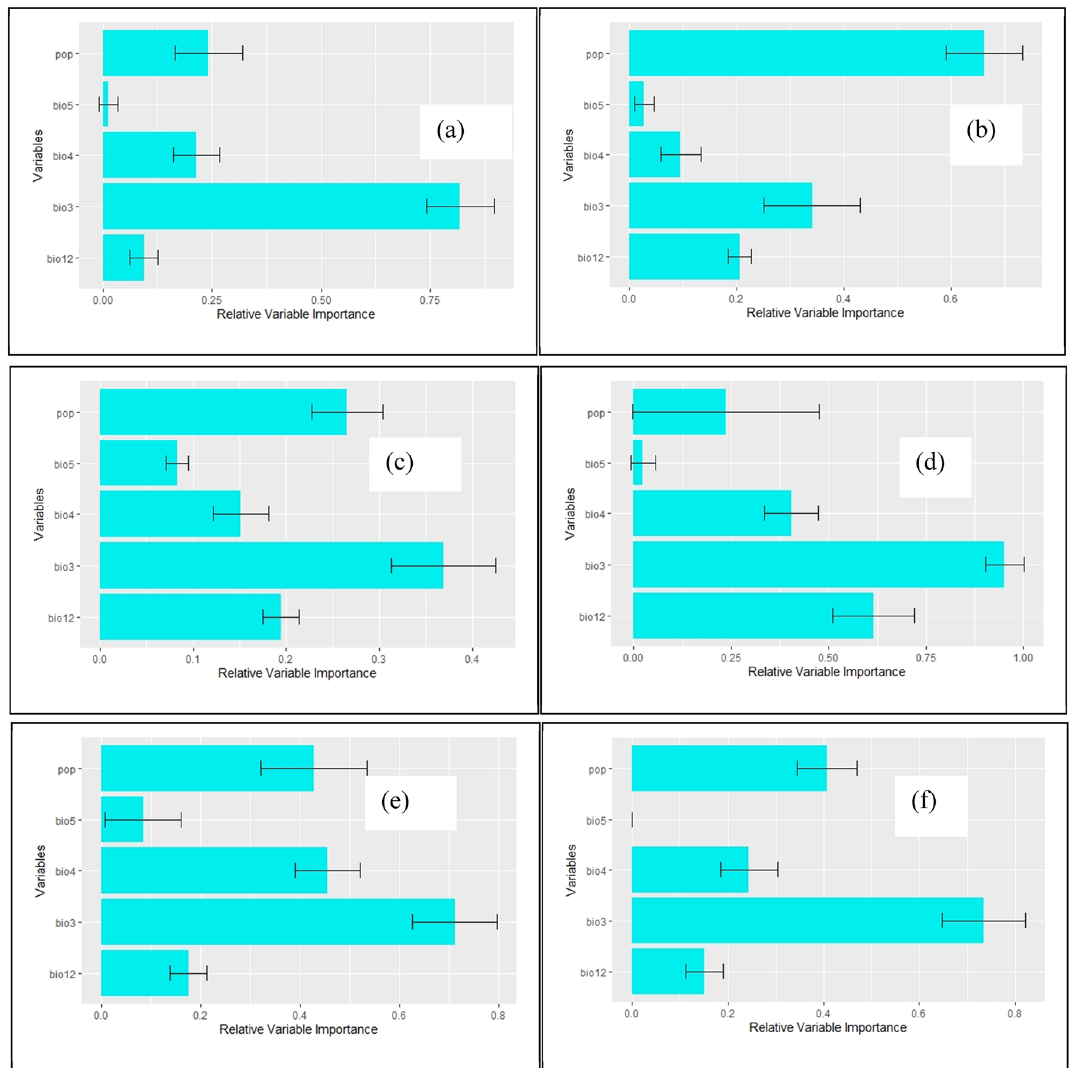
Figure 2. Relative importance of the environmental variables in the models: ( a ) Maxent, ( b ) BRT, ( c ) RF, ( d ) GLM, ( e ) GAM, and ( f ) MARS (the histograms were generated using R version 4.1.3 (https:// www.R- proje ct.